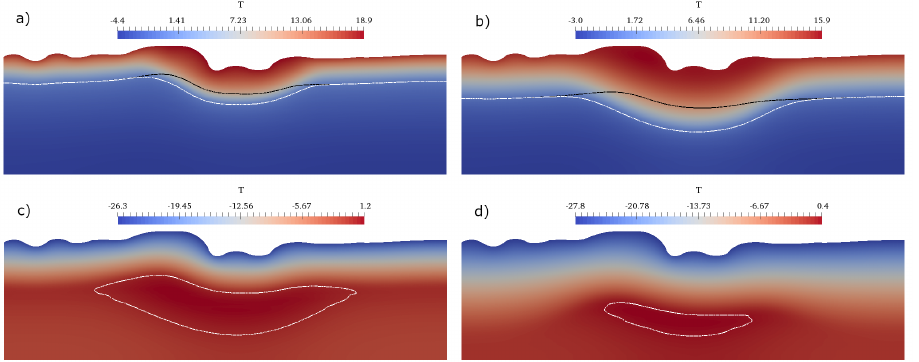
Figure 5. Numerical results for temperature ( a ) τ = 150 ( b ) τ = 200 ( c ) τ = 320 ( d ) τ = 365. Where the white line is the isocline of zero for saturated soils and the black line is the isocline of zero for non-saturated soils. This results are coarse grid solution using 8 basis functions ( DOF c =